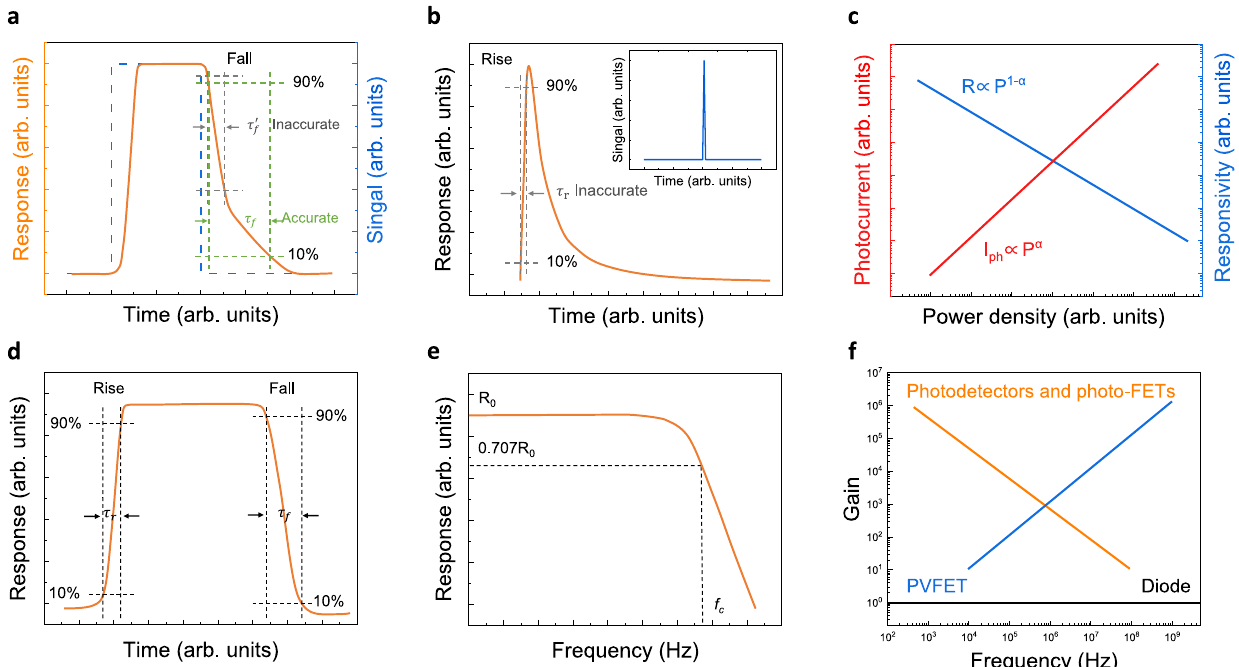
Fig. 6 | Time parameters and gain determination of 2D photodetectors. a Calculatedfalltime does not reacha stablevalue whichisinaccurate, where τ 0 f is inaccurate calculated fall time, τ f is accurate calculated fall time. (The bule line represents the square signal curve, the yellow line represents the typical response curve of 2D photodetectors.) b Response time measurement of photodetector may not reach a stable value under pulse signal, which will lead to an inaccurate result. The inset shows pulse signal. The τ r is inaccurate calculated rise